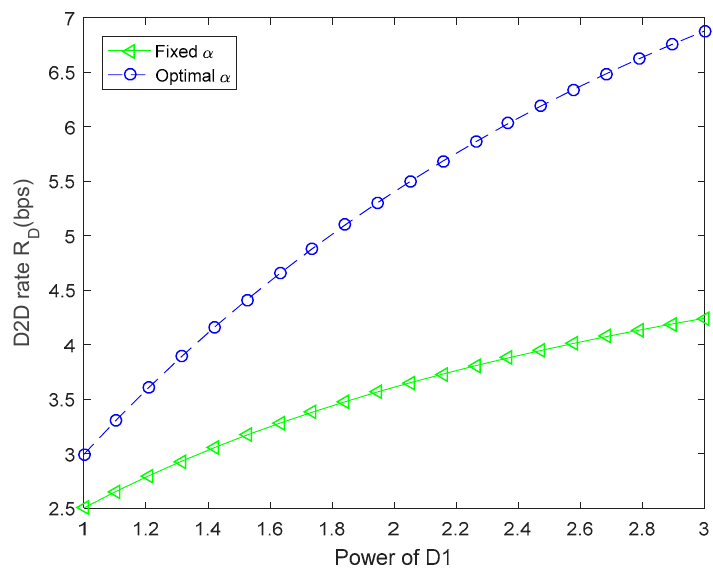
Figure 8. The Optimal D2D link rate versus power of D1.